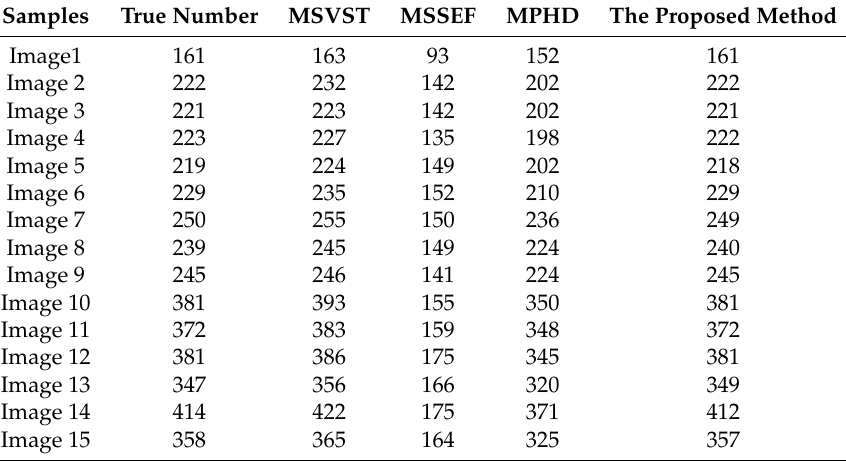
Table 2. Comparison evaluation of the overall number of detected